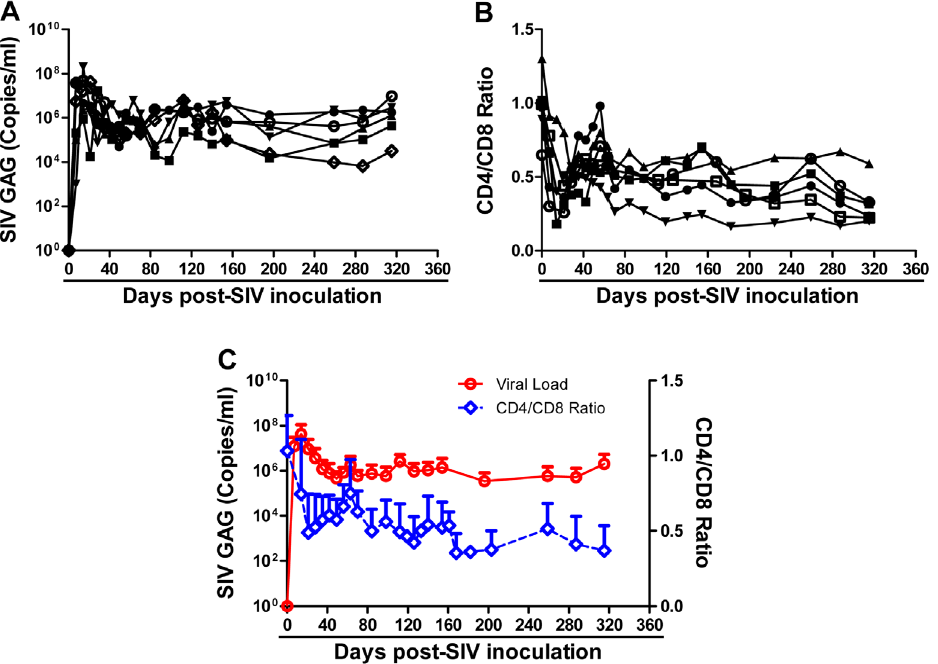
Figure 1. SIV infection of Chinese rhesus monkeys. Six animals were intravenously inoculated with SIVmac239 (10 3 TCID50). Blood samples were collected from the animals at the indicated time points postinfection. A: Plasma levels of SIV GAG gene RNA were measured by real-time PCR. B: CD4/CD8 ratios were measured by flow cytometry. C: Average SIV loads and CD4/CD8 ratios (mean 6 SEM) of SIV-infected animals. doi:10.1371/journal.pone.0098636.g001 PLOS ONE |